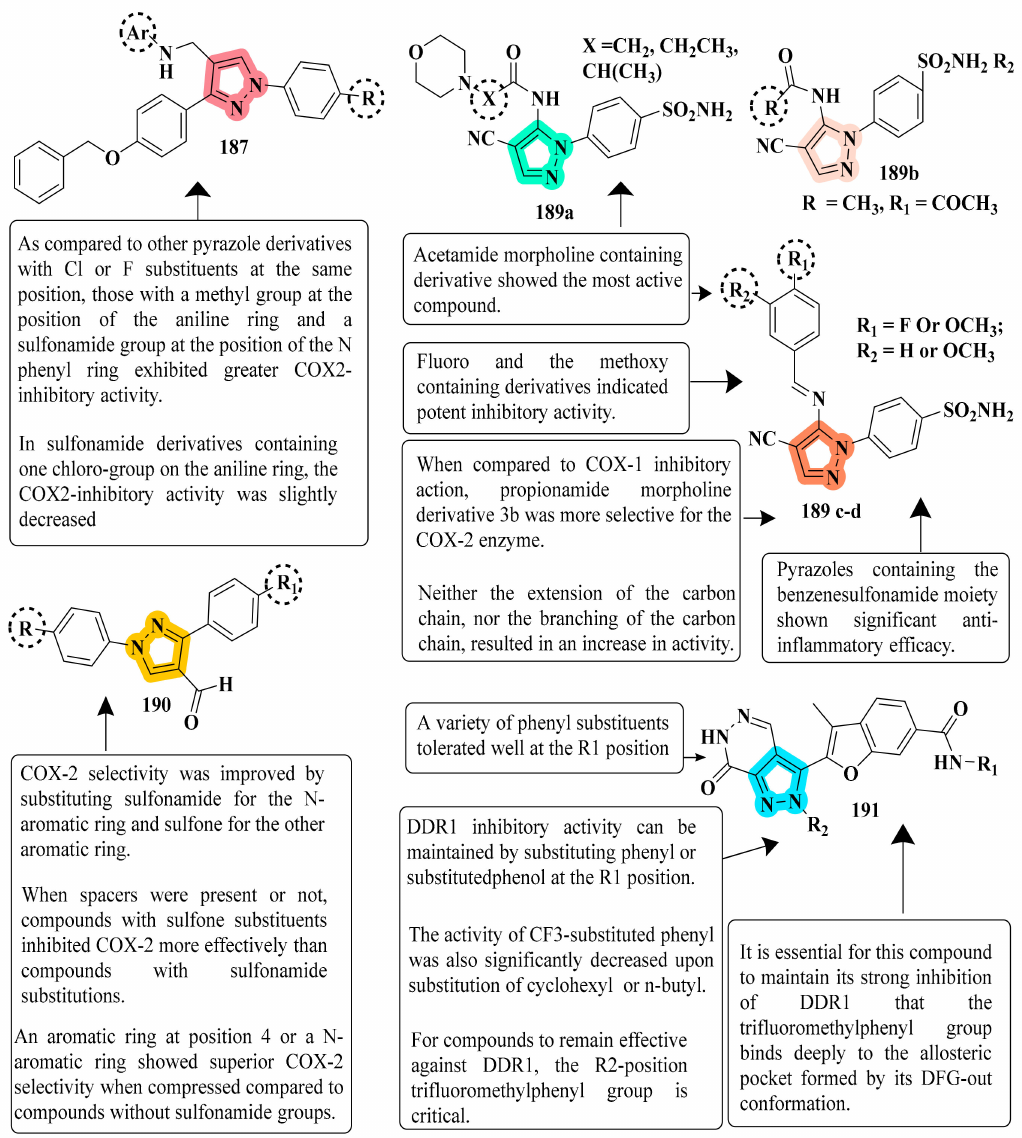
Figure 8. Structure and SAR of potent anti-inflammatory activity compounds 187 , 189 , 190 and 191